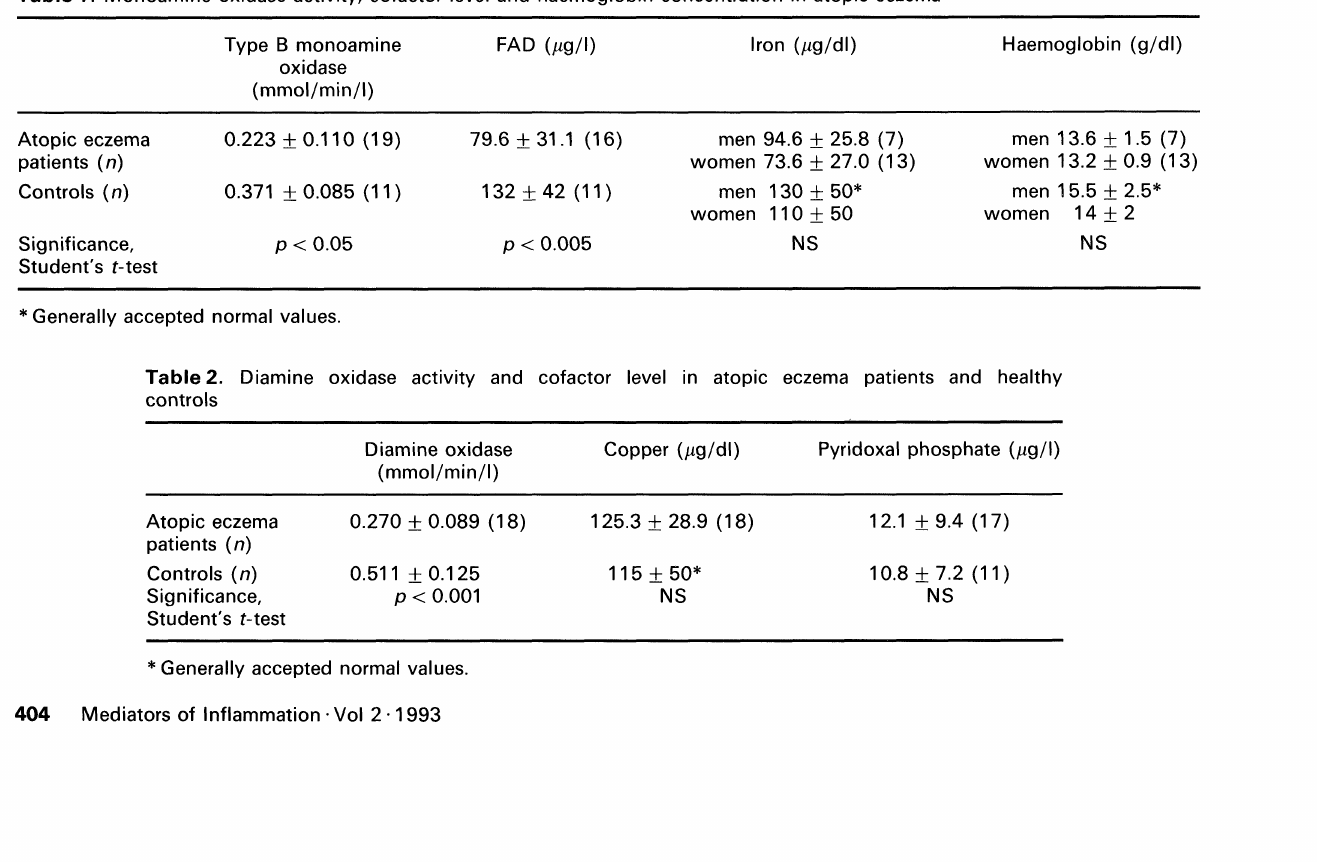
Table 1. Monoamine oxidase activity, cofactor level and haemoglobin concentration in atopic eczema